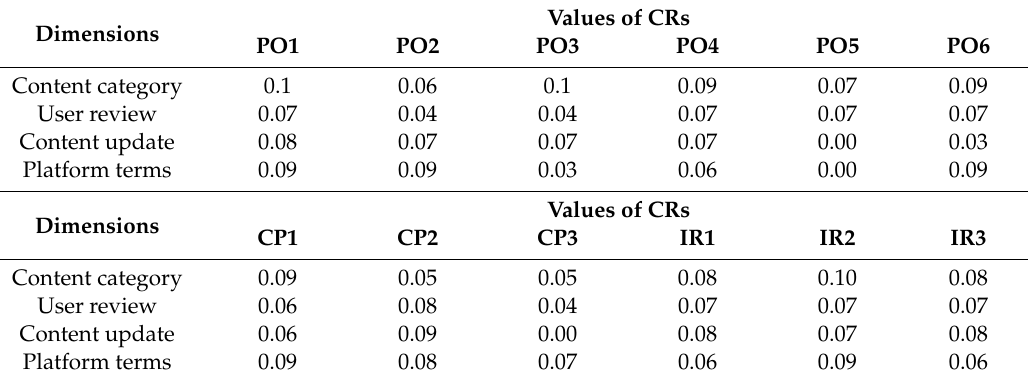
Table 2. CRs of the Questionnaires.